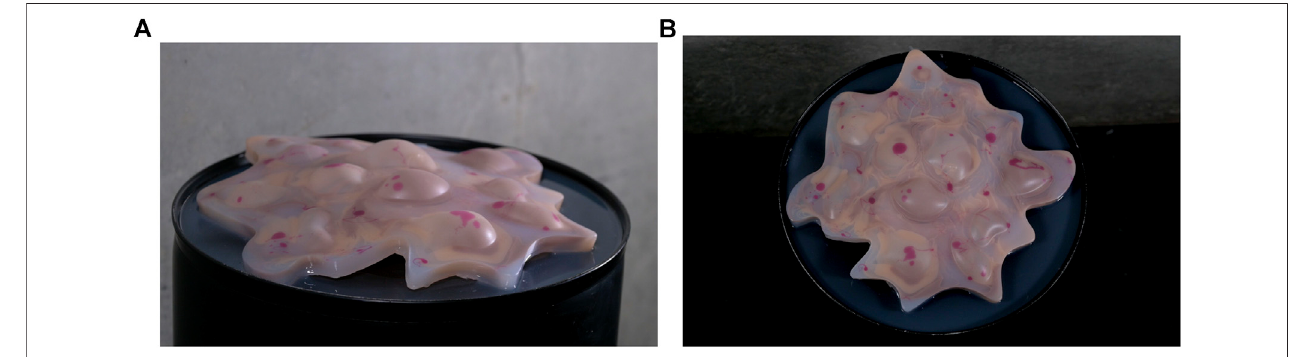
FIGURE 1 | The SON Ō robot. Side view (A) and top view (B)